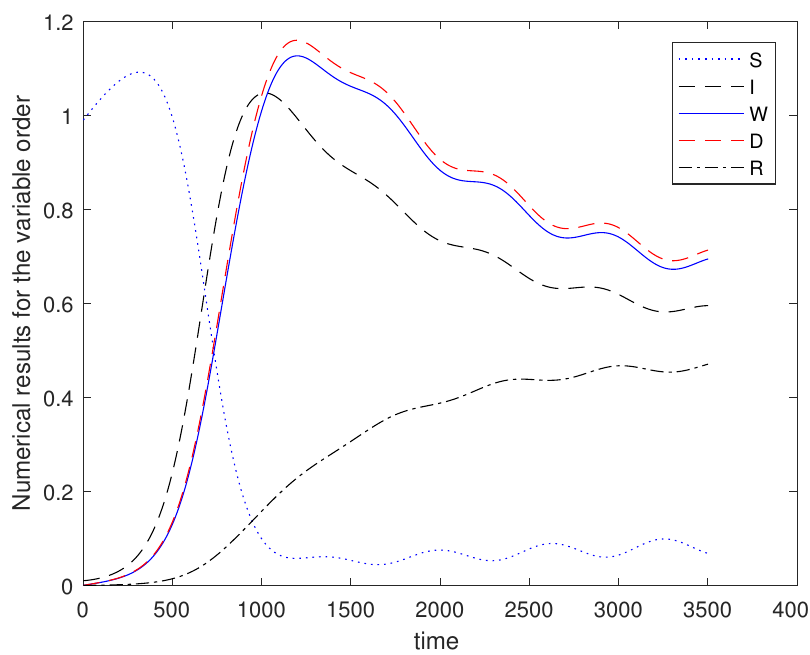
Figure 7. Numerical solution of the mathematical model (17) for the variable order 1 − 0.006 ∗ ( sin ( t ))